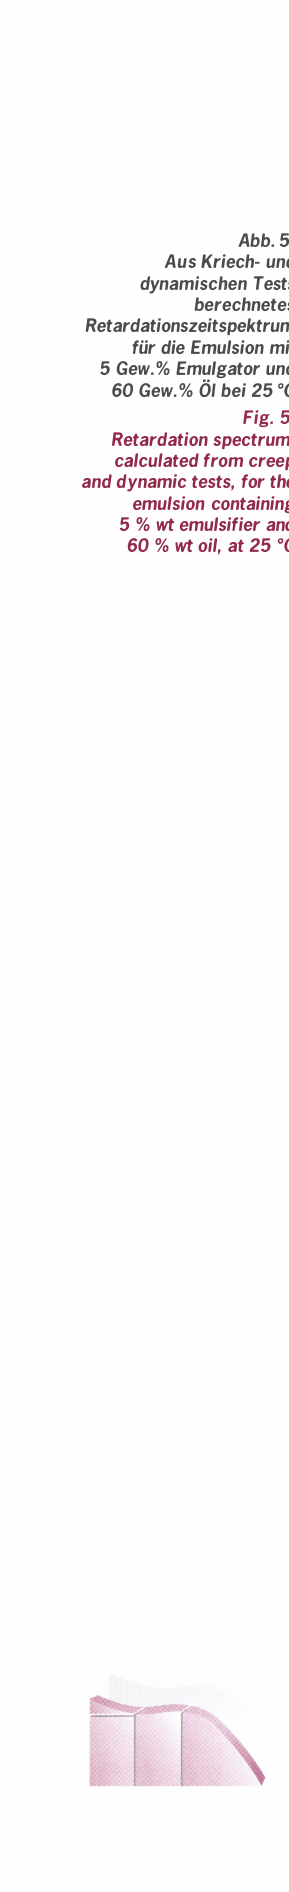
der Kriechnachgiebigkeit der Emulsion mit 5 Gew.% Emulgator und 50 Gew.% 01 bei 25 •c Experimental and recalculated values of the creep compliance for the emulsion containing